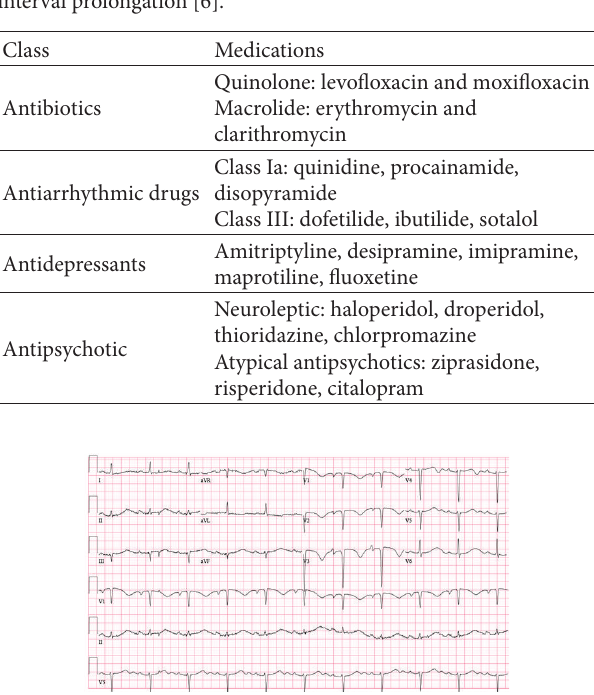
Table 1: Few of the major classes of medications known to cause QT interval prolongation [6].